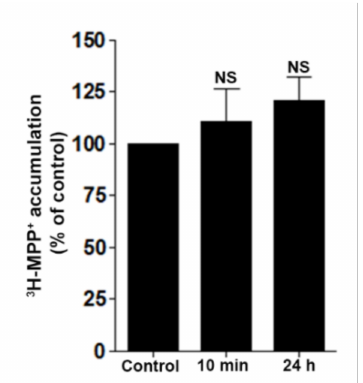
Figure 6. Effects of DD-218 on OCT2 function in renal tubular cells. 3 H-MPP + uptake in